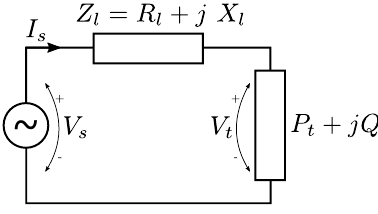
Figure 1. Steady state equivalent